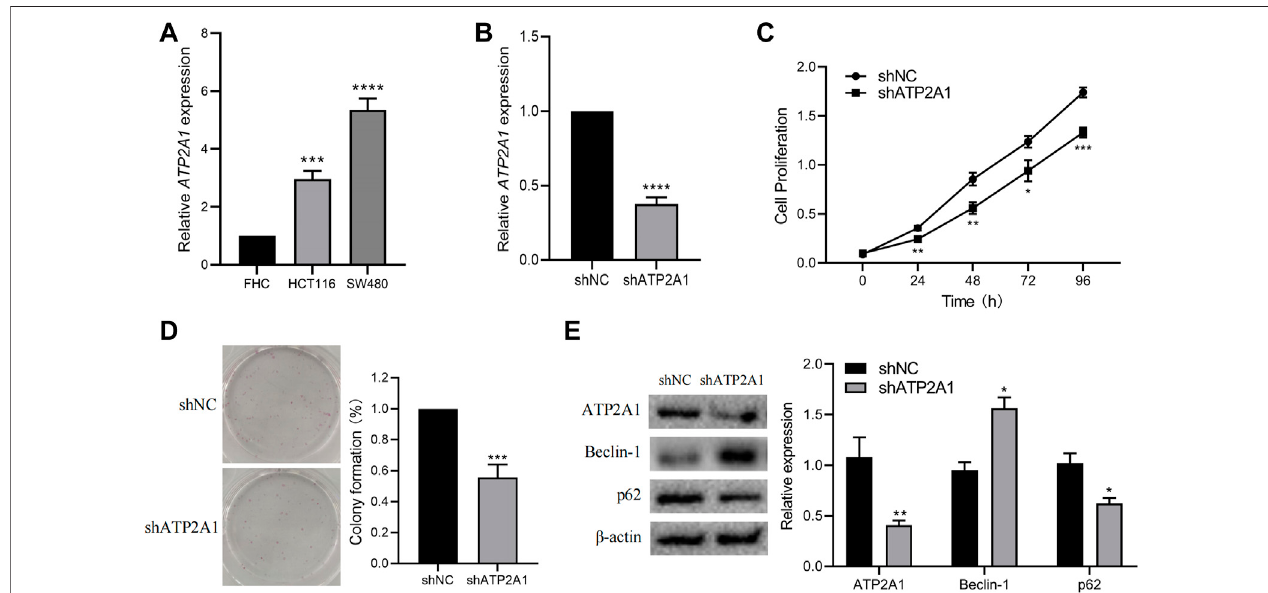
FIGURE7| Knockdownof ATP2A1 inhibitstheproliferationofCRCcellsandautophagypathway. (A) ThemRNAlevelof ATP2A1 inFHC,HCT116andSW480. (B) Knockdown of ATP2A1 in SW480 treated with shRNA. (C) The cell proliferation at each time point via CCK8 assay. (D) The colonies of SW480 cells with different treatments. (E) The expression of key proteins of autophagy pathway in both groups. * p < 0.05, ** p < 0.01, *** p < 0.001, **** p < 0.0001 vs. shNC.